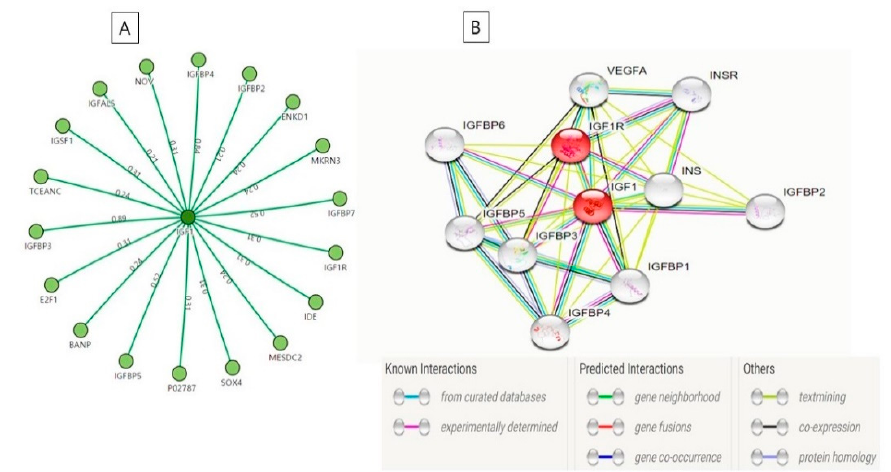
Figure 3. Protein-Protein interactions of IGF-1 with its associated proteins generated by ( A ) SIGnaling Network Open Resource, ( B ) STRING.